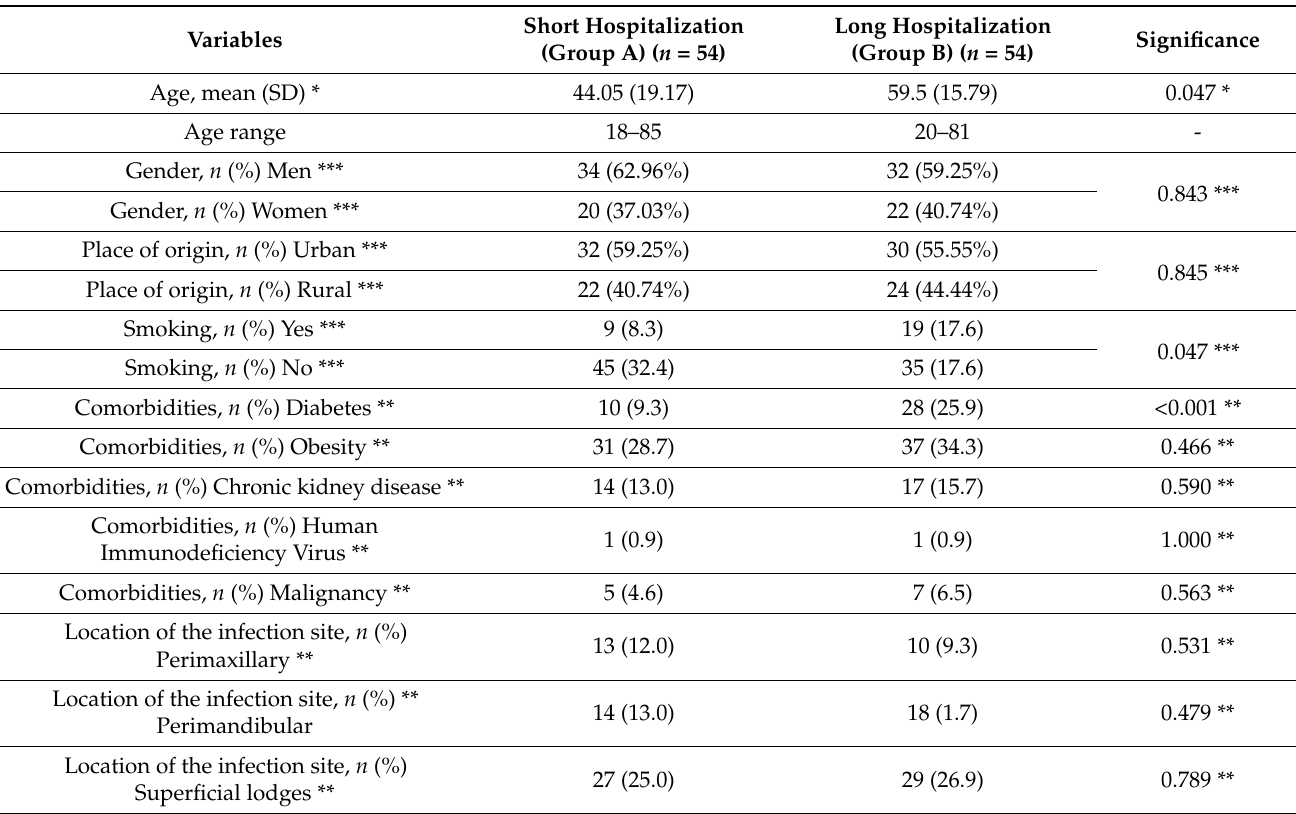
Table 1. Patients’ characteristics.